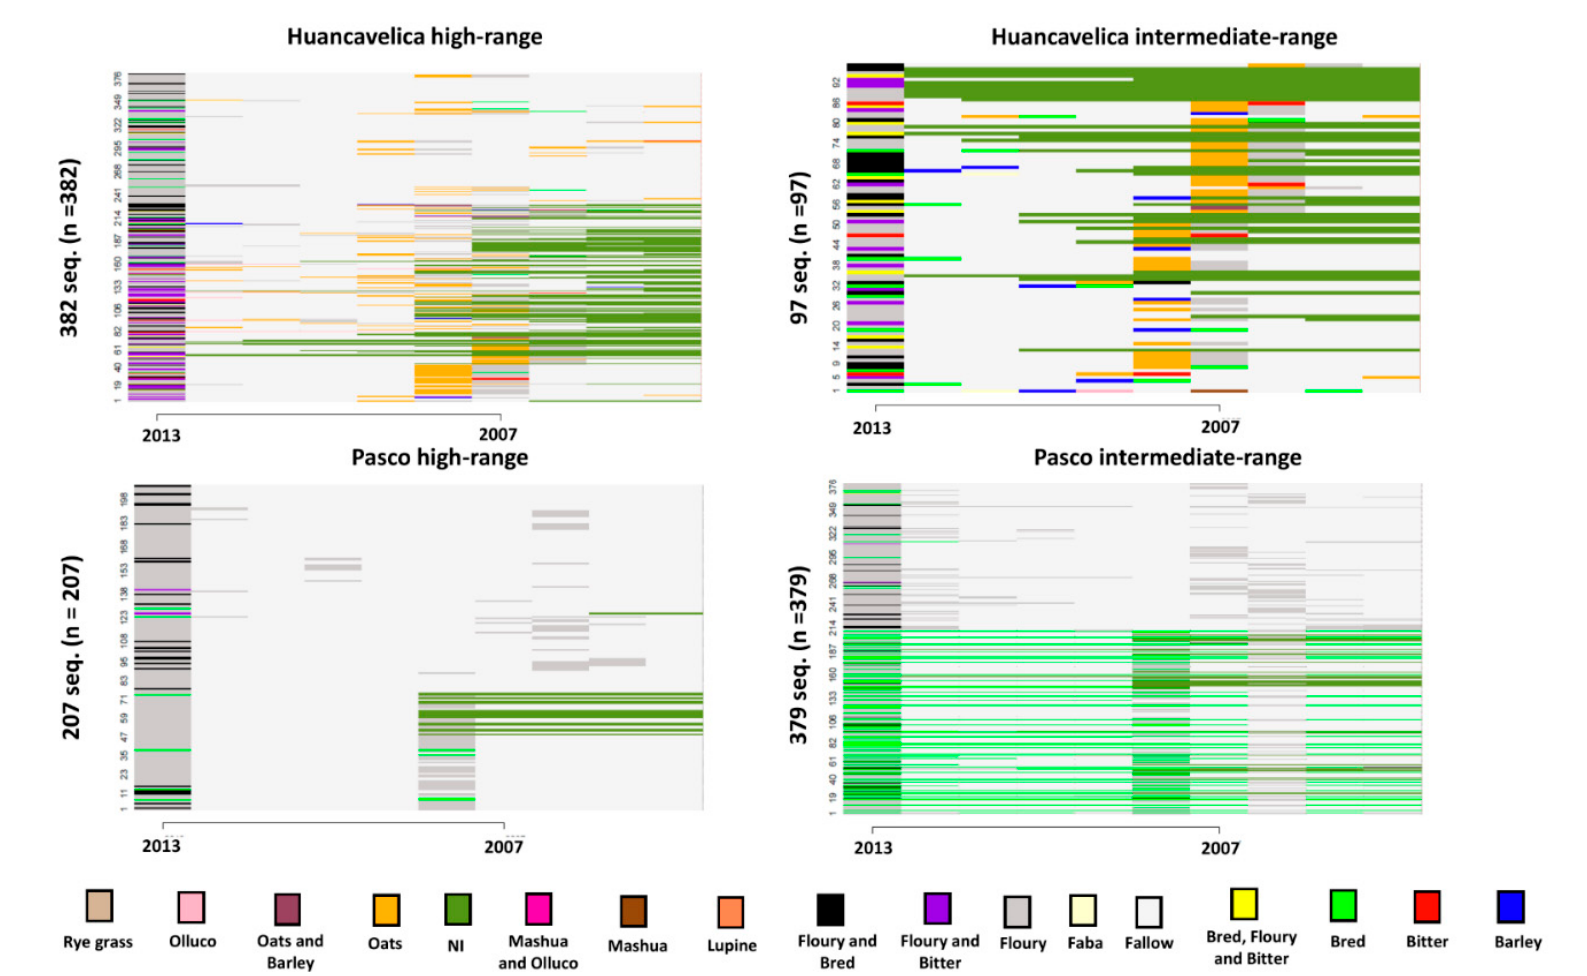
Figure 5. Pattern analysis of cropping sequences for intermediate and high-range altitude fields in each landscape, illustrating higher occurrence of potato rotations with other crop species (i.e., cereals) in Huancavelica. In the legend, NI refers to No Information.